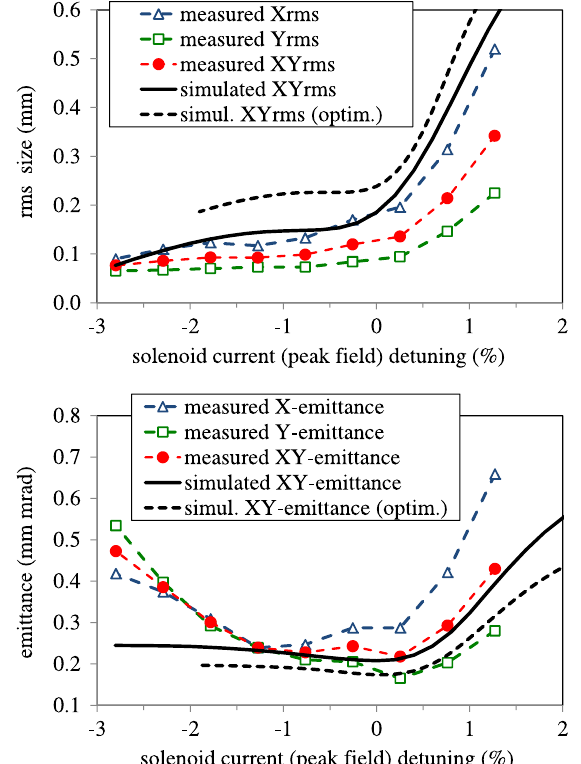
FIG. 24. Measured and simulated rms size (upper plot) and emittance (bottom plot) for 0.1 nC versus main solenoid current detuning. The optimum solenoid current from the experimental ¼ 393 A corresponds to the simulated optimum peak data I (cid:6) main field of (cid:2) 0 : 226 71 T . Results of the optimized simulations (see Table I for the parameters) are shown with dashed